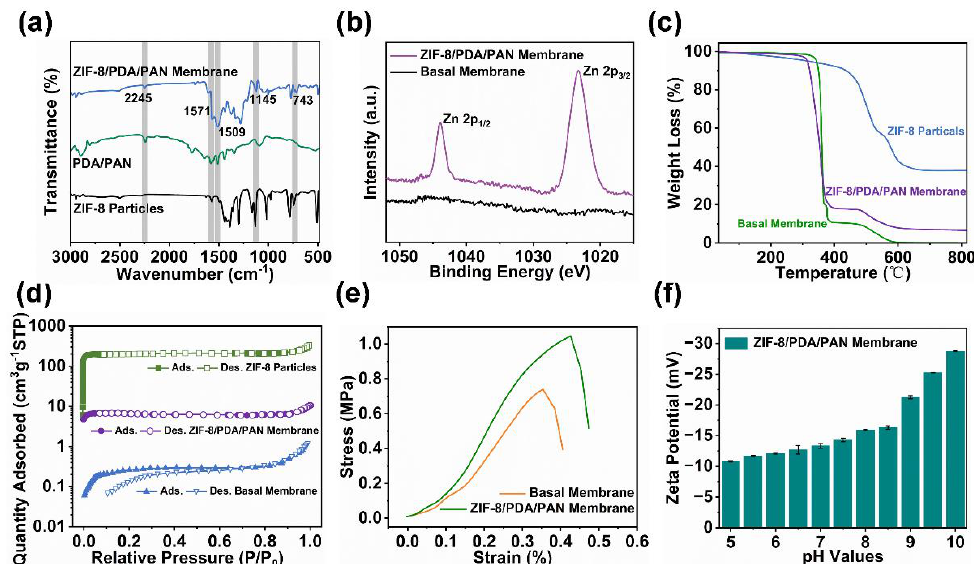
Figure 4. ( a ) ATR − FTIR spectra of the ZIF – 8 particles, PDA/PAN membrane, and ZIF – 8/PDA/PAN membrane. ( b ) XPS spectra of the zinc element of the basal and ZIF-8/PDA/PAN membranes. ( c ) TG curves and ( d ) N 2 adsorption – desorption isotherms of the ZIF – 8 particles, basal membrane, and ZIF – 8/PDA/PAN membrane. ( e ) Stress – strain curves of basal and ZIF – 8/PDA/PAN membranes. ( f ) Zeta potential of the ZIF – 8/PDA/PAN membrane.